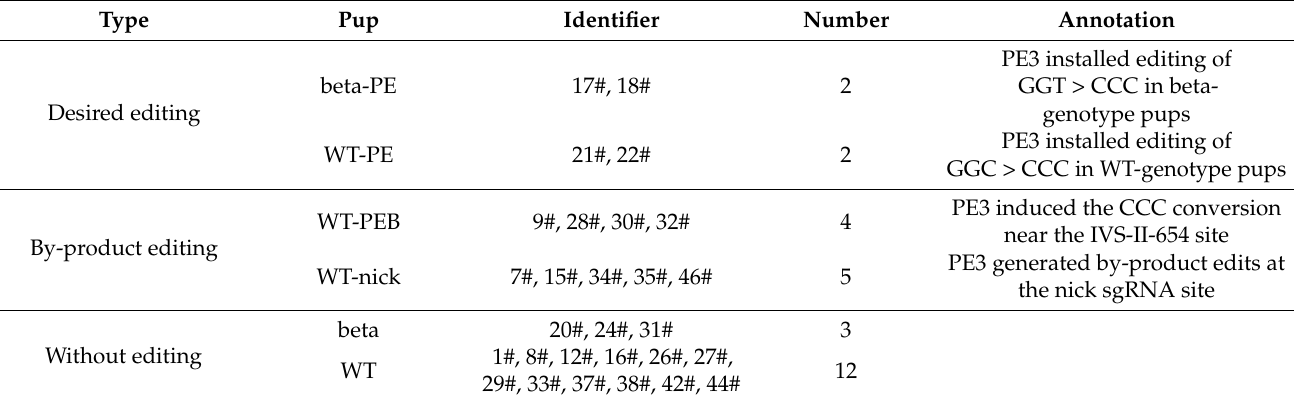
Table 1. PE3-induced editing outcomes in the F0